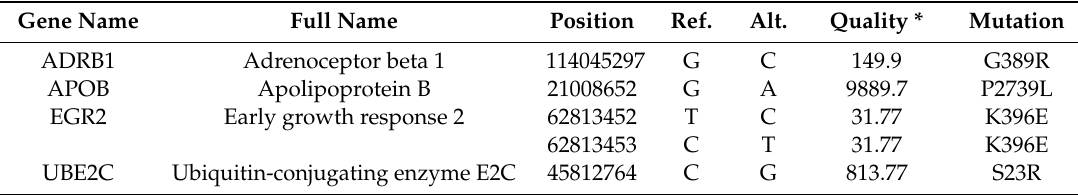
Table 1. CPO induced point mutations in Huh7